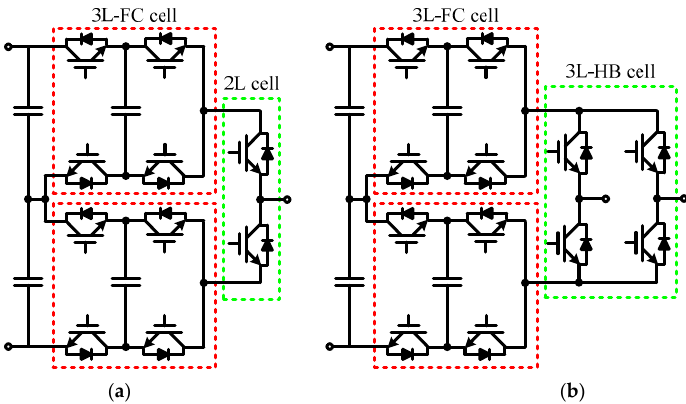
Figure 9. Hybrid multilevel converters based on cascading basic cells. ( a ) 5L DFC ‐ ANPC converter